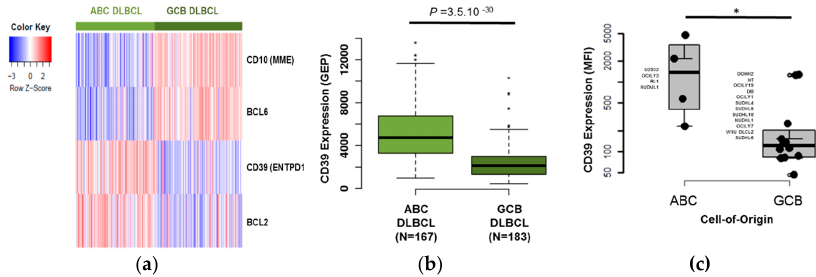
Figure 2. CD39 expression discriminates between GCB and ABC DLBCL primary tumors and cell lines. Cluster gram showing the expression of MME, BCL6, ENTPD1 , and BCL2 genes in ABC DLBCL samples ( n = 167) and GCB DLBCL samples ( n = 183) in the ABC and GCB DLBCL samples from the R-CHOP and CHOP Lenz cohorts (gene expression profile, GEP, data) ( a ). (B) Boxplots illustrate the expression signal (GEP) of ENPD1 in ABC DLBCL samples and in GCB DLBCL samples in the Lenz cohort ( b ). Boxplots showing CD39 mean fluorescence intensity (MFI, logarithmic scale) in 16 DLBCL derived-cell lines ( c ). The boxes indicate the 25th and 75th percentile values. The line in the middle corresponds to the median. The vertical lines, to the 10th and the 90th percentiles. The outliers are identified as the third quartile plus 1.5 IQR (interquartile range); * p -value < 0.05 (Mann-Whitney